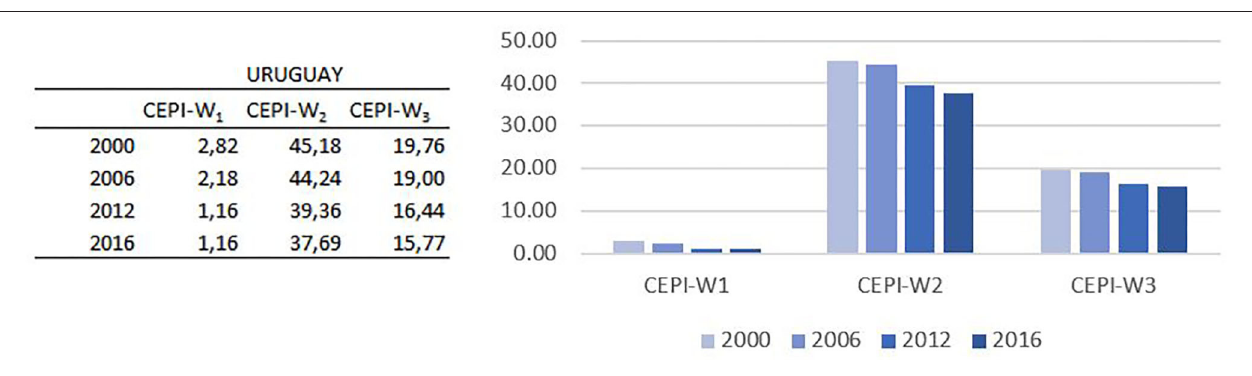
FIGURE 8 | CEPI — Uruguay (2000, 2006, 2012, 2016).